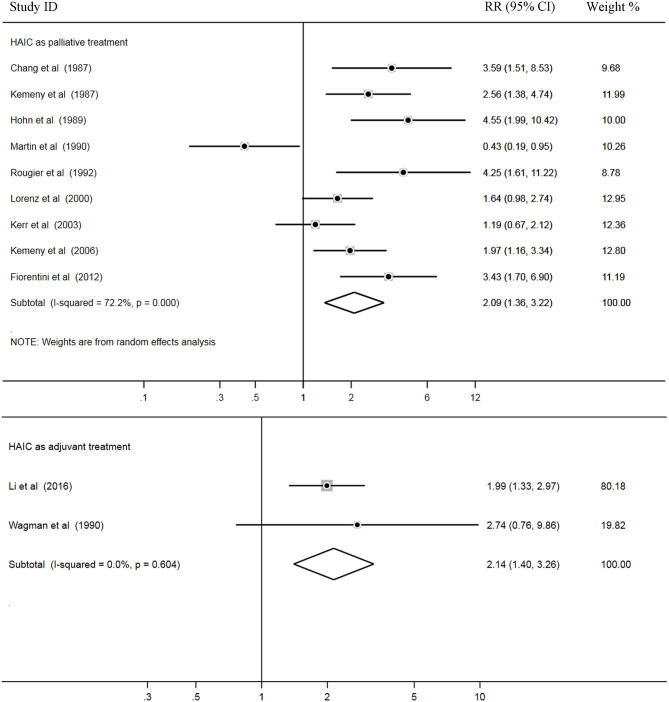
Forest plot of relative risk (RR) for tumor response rates.